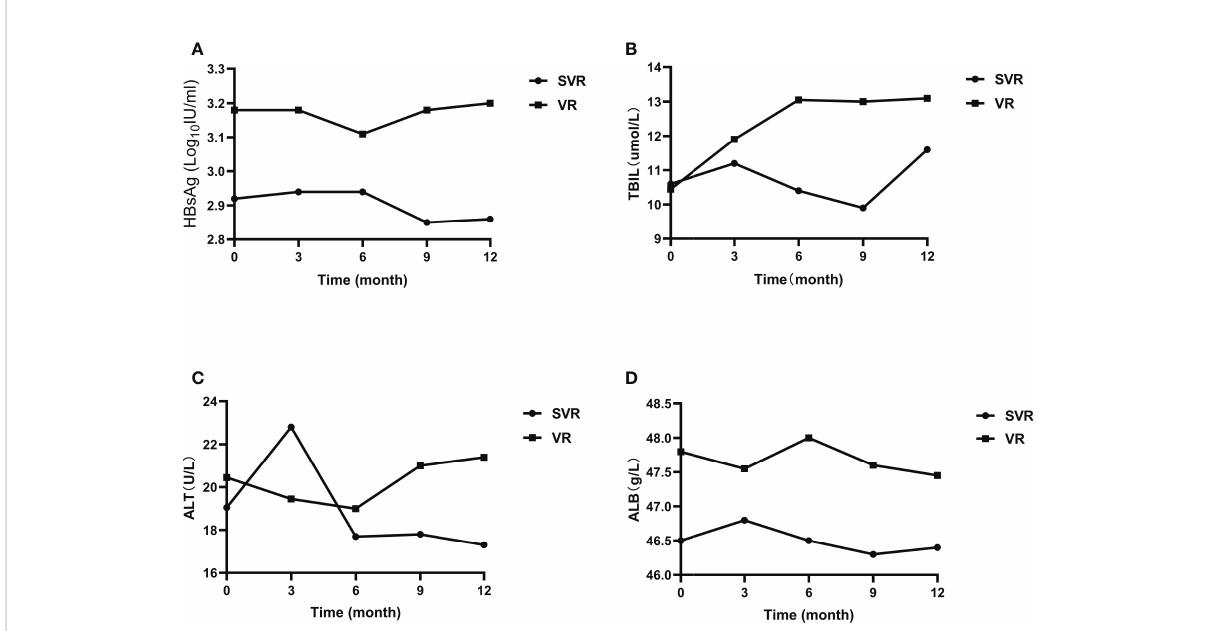
FIGURE 3 Clinical indicators of patients with sustained virological response and viral relapse. (A) the change of HBsAg; (B) the change of TBIL; (C) the change of ALT; (D) the change of ALB. SVR, sustained virological response; VR, viral